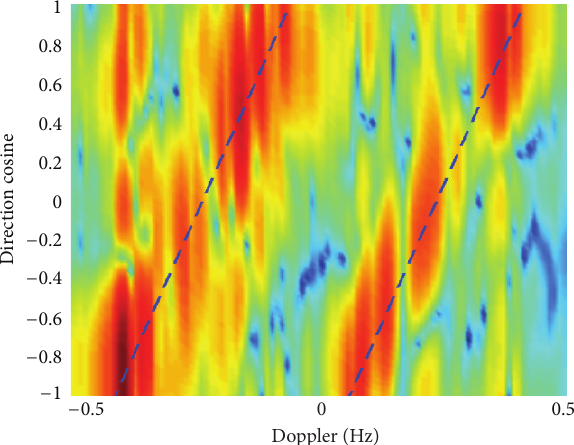
Figure 4: Azimuth estimated RMSE versus SNR.